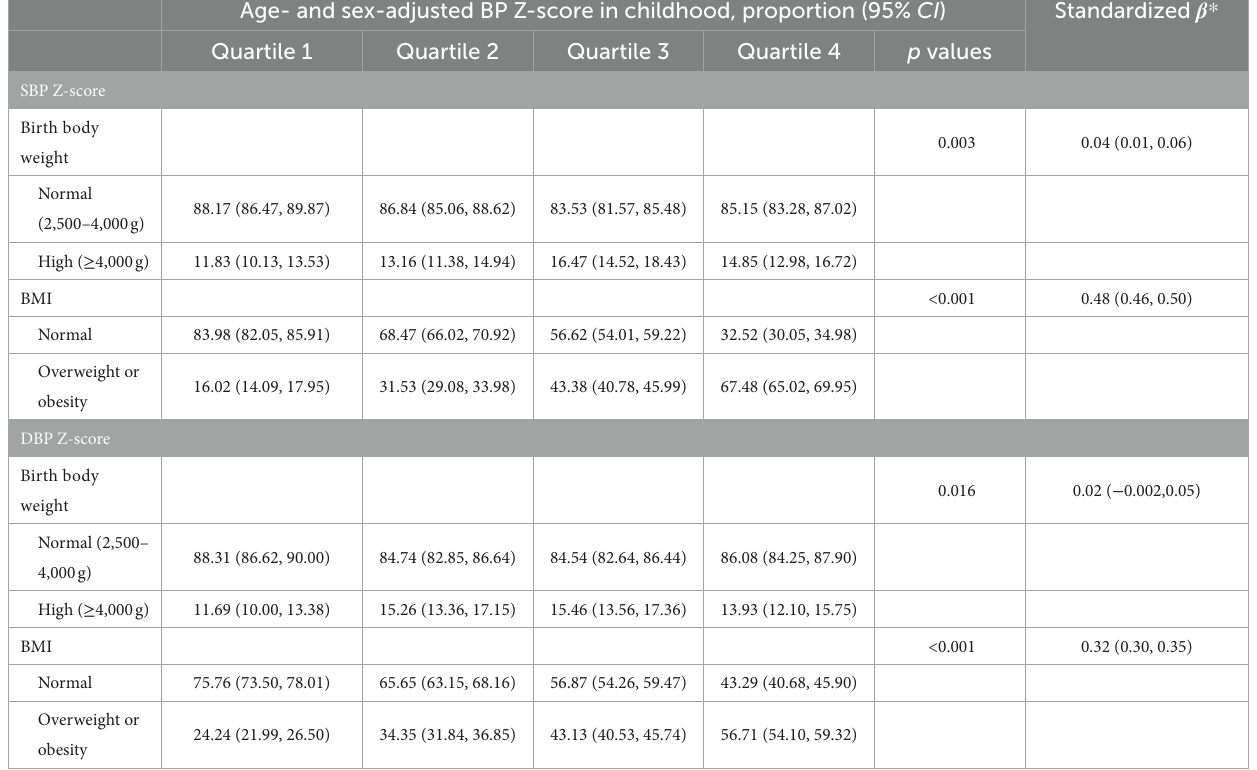
* Standardized β : Standardized linear regression coefficients of birth weight or BMI with BP with adjustment for age and sex.